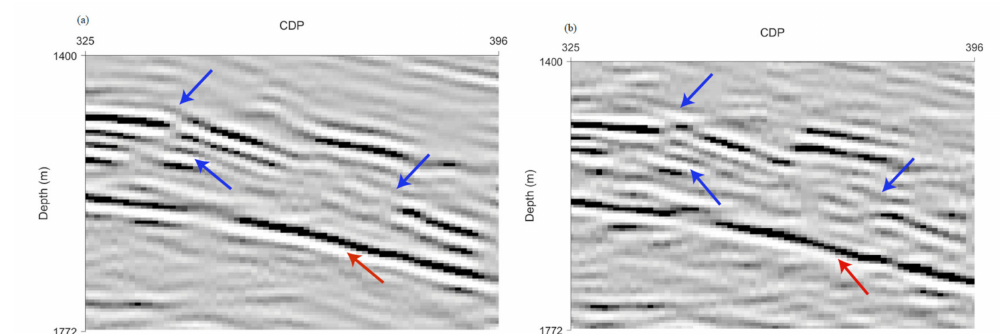
Figure 4. Details of the black dashed box (in Figure 3) using different migration methods: ( a ) the con- ventional one-way wave equation migration; and ( b ) amplitude-preserved one-way wave equation migration. The red arrows indicate the BSR and the blue arrows indicate other reflectors above